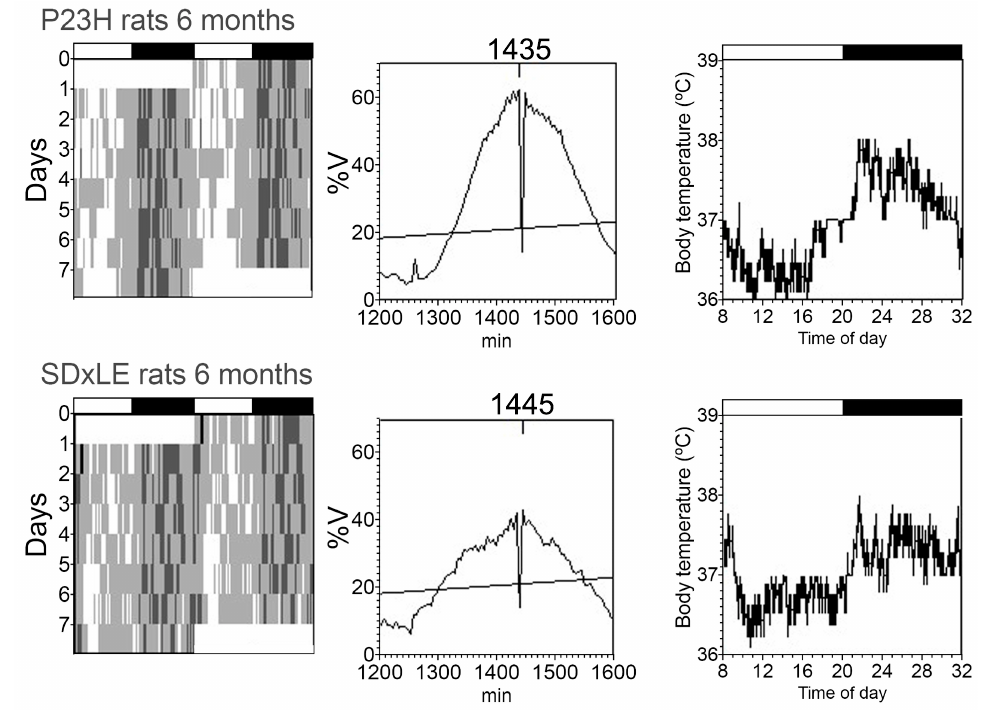
Figure 5. Representative actograms (left), periodograms (middle), and mean waveforms (right) obtained analyzing core-body temperature rhythms at P180 in P23H and SD × LE rats with epigallocatequin gallate (EGCG) treatment. The light/dark cycle is represented by white and dark horizontal bars, respectively.